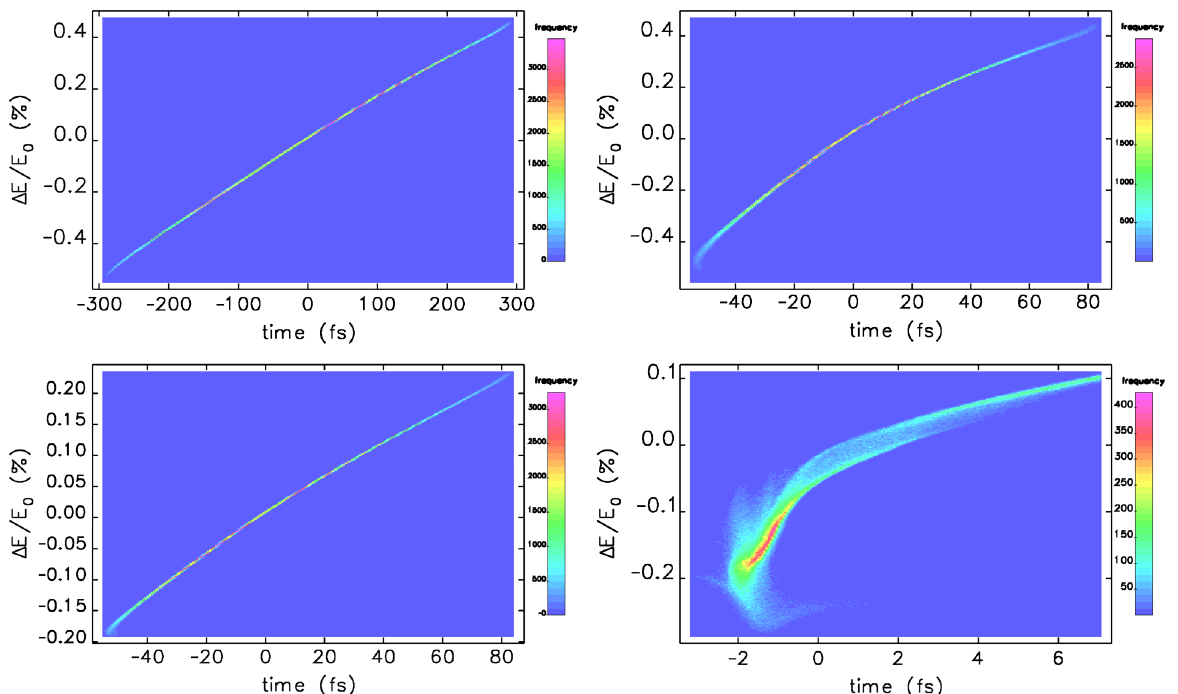
FIG. 5. Longitudinal phase space evolution during the acceleration and bunch compression process. Observing locations from left top, right top to left bottom and right bottom: Linac1 end; bunch compressor one end; Linac2 end; bunch compressor two end. The rms electron bunch length is undercompressed from 140 to 34 fs in a first stage bunch compression, then further undercompressed to 2 fs in a second stage bunch